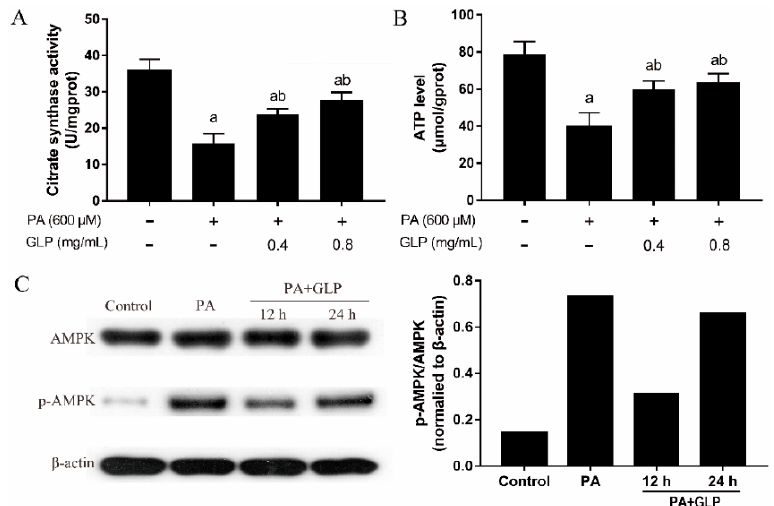
Figure 4. The effects GLP and PA on mitochondrial energy metabolism in IPEC-J2 cells. Cells were treated with 600 µ M PA or/and GLP (0.4 and 0.8 mg/mL) for 24 h. ( A ) Citrate synthase activity was assayed using a citrate synthase assay kit and expressed as U/mg protein ( n = 5). ( B ) Mitochondrial proteins were extracted using a mitochondria isolation kit after cells were lysed. The ATP level was determined by bioluminescence measurement and expressed as µ mol/g protein ( n = 5). ( C ) Representative Western blot of AMPK and p-AMPK. The data were quantified and normalized to β -actin. Data were presented as mean ± SE for three independent experiments, a < 0.01 vs. control, b < 0.01 vs. PA alone.